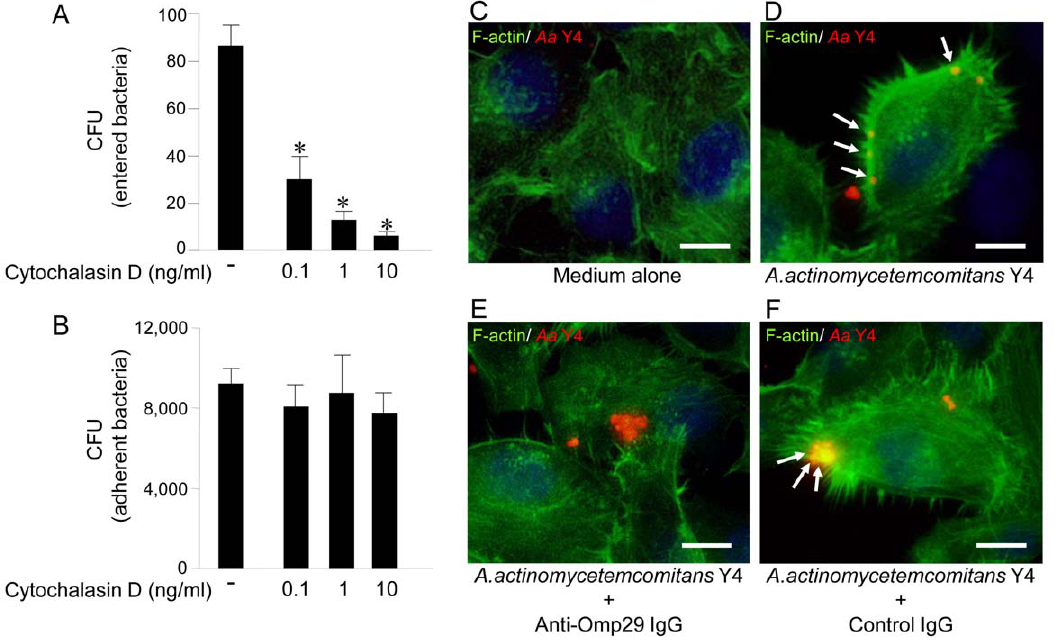
Figure 4. Bacterial Omp29 up-regulates F-actin rearrangement in OBA9, which results in induction of Aa Y4 entry into OBA9. (A and B) Aa Y4 harvested at mid-log growth was incubated with confluent OBA9 cells (5 6 10 5 bacteria/100 m l/well) in the presence or absence of cytochalasin D (F-actin rearrangement inhibitor) by the indicated concentration in the figures. The number of bacteria entered or adherent to OBA9 cells was shown (A, bacterial entry; B; bacterial attachment). *, Significantly lower than control medium alone by Student’s t test ( P , 0.05). (C–F) After pretreatment of sub confluent OBA9 cells with or without anti-Omp29 IgG (10 m g/ml) or control non-immunized IgG (10 m g/ml) for 15 min, OBA9 cells were co-cultured with Aa Y4 (1 6 10 7 bacteria/2 ml/dish) in the antibiotics-free K-SFM for 1 hr. F-actin (green) and Aa Y4 (red) were observed using immunofluorescence microscopy in OBA9 cells. White arrow indicates co-localization (yellow) of F-actin and Aa Y4. (C) medium alone, (D) Aa Y4, (E) anti-Omp29 IgG and Aa Y4, and (F) control IgG and Aa Y4. Scale bar: 10 m m.